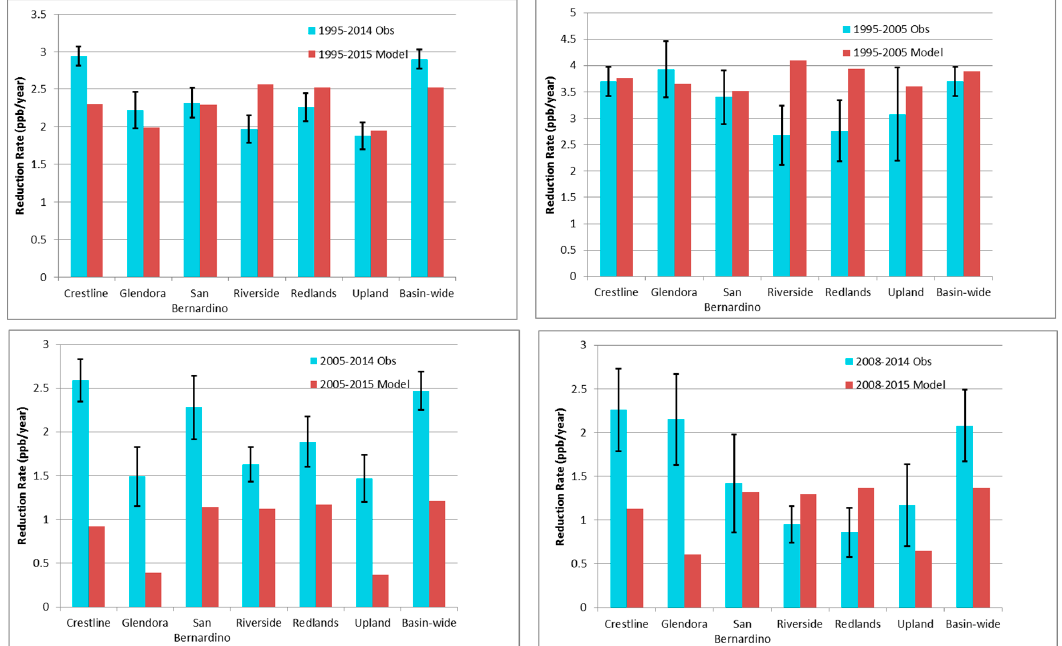
Figure 11. Multi-year modeled and observed reduction rates of 5-year ozone design values at selected monitors using the 2016 AQMP modeling database for the periods from 1995 to 2015 ( top left ), 1995 to 2005 ( top right ), 2005 to 2015 ( bottom left ), and 2008 to 2015 ( bottom right ). The observed rates include error bars to indicate the uncertainty in their calculation.